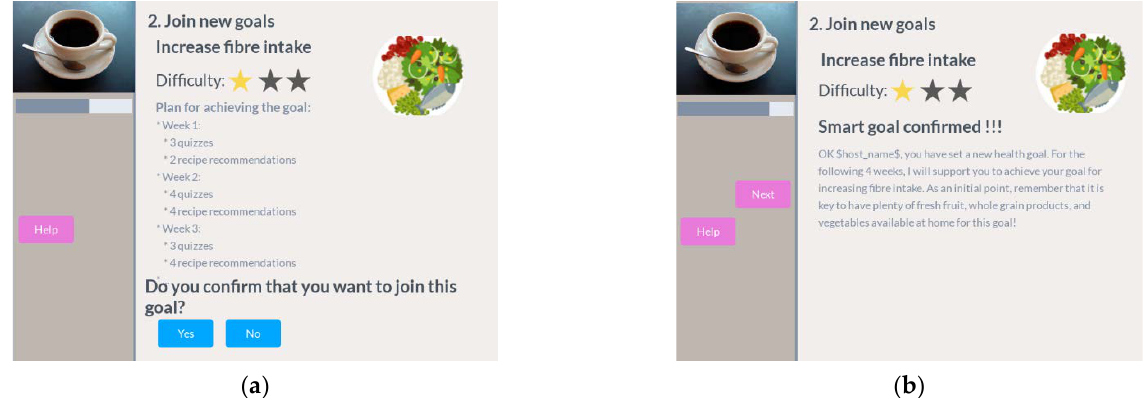
Figure 14. Join goal in coffee session. ( a ) Plan summary and confirmation; ( b ) confirmation and motivational message.